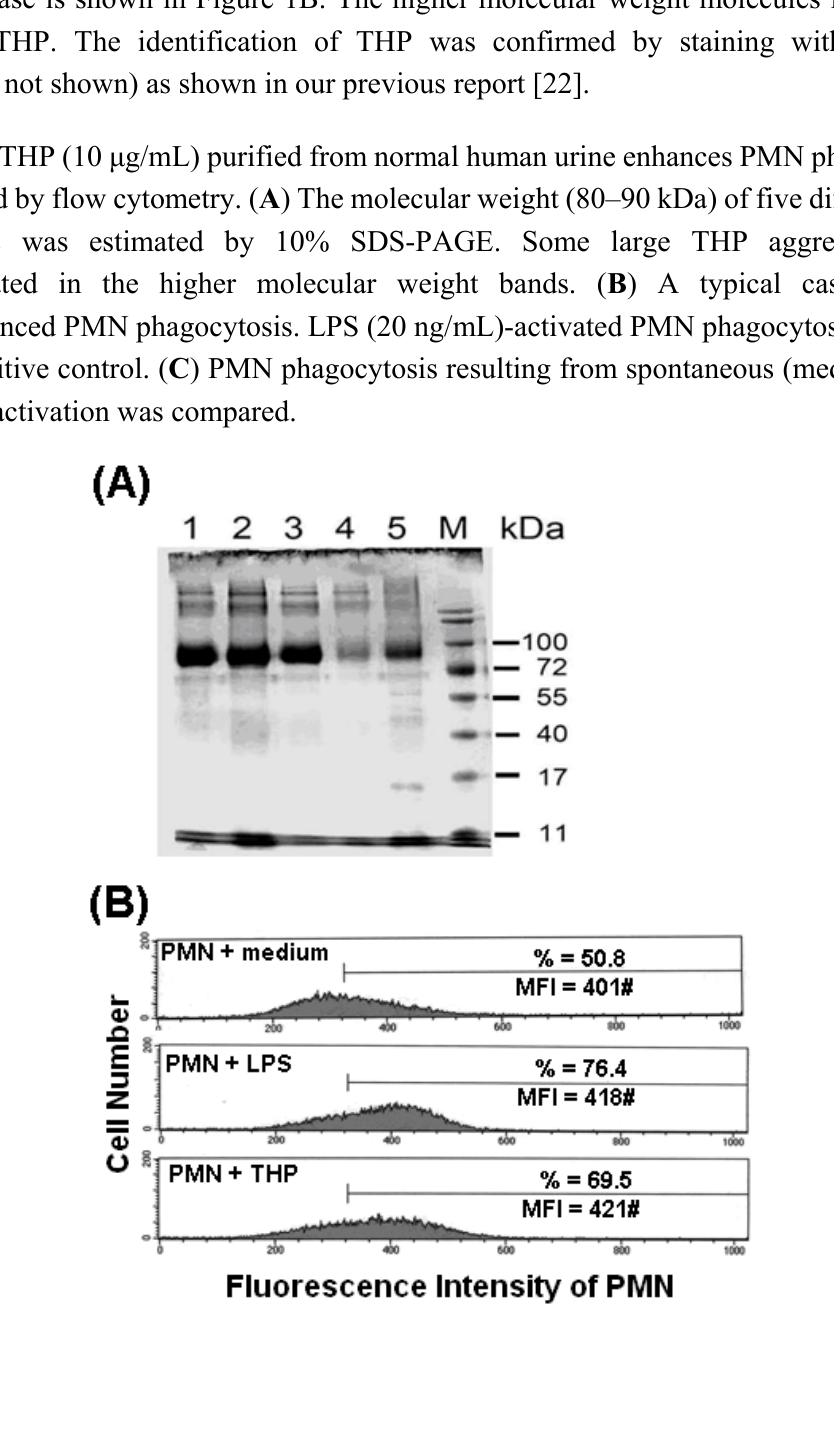
Figure 1. THP (10 μ g/mL) purified from normal human urine enhances PMN